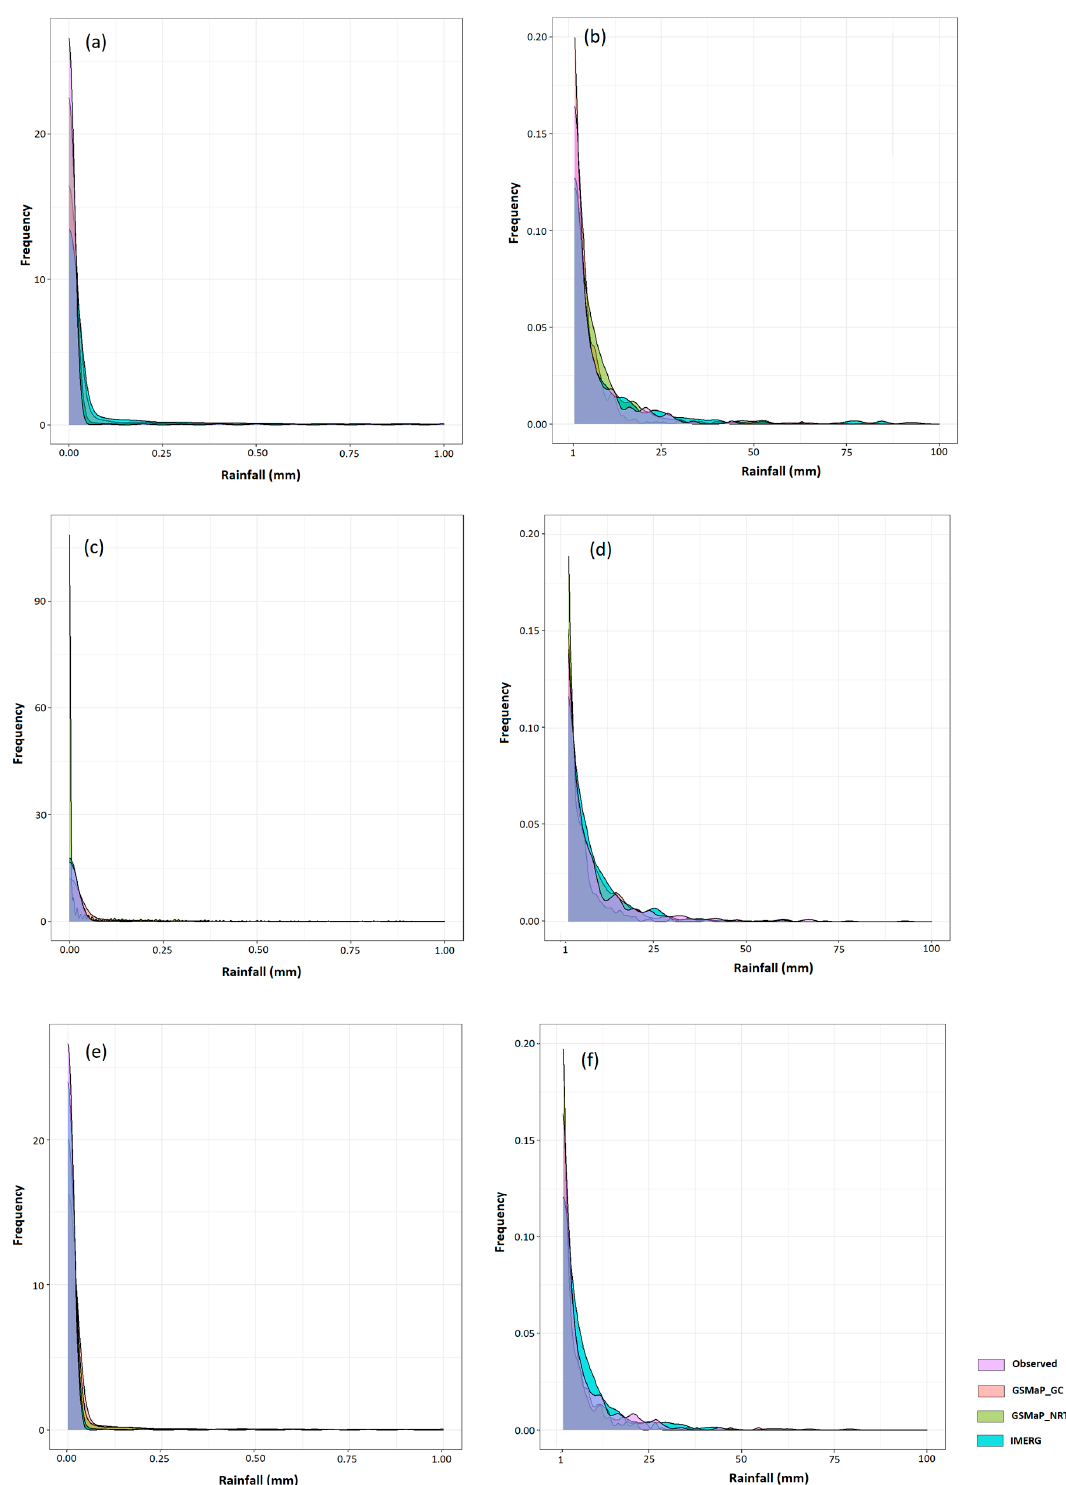
Figure 6. Distribution plots of in situ and satellite daily rainfall data at Baghdad ( a , b ), Mosul ( c , d ), and Basrah ( e , f ). and Basrah ( e , f